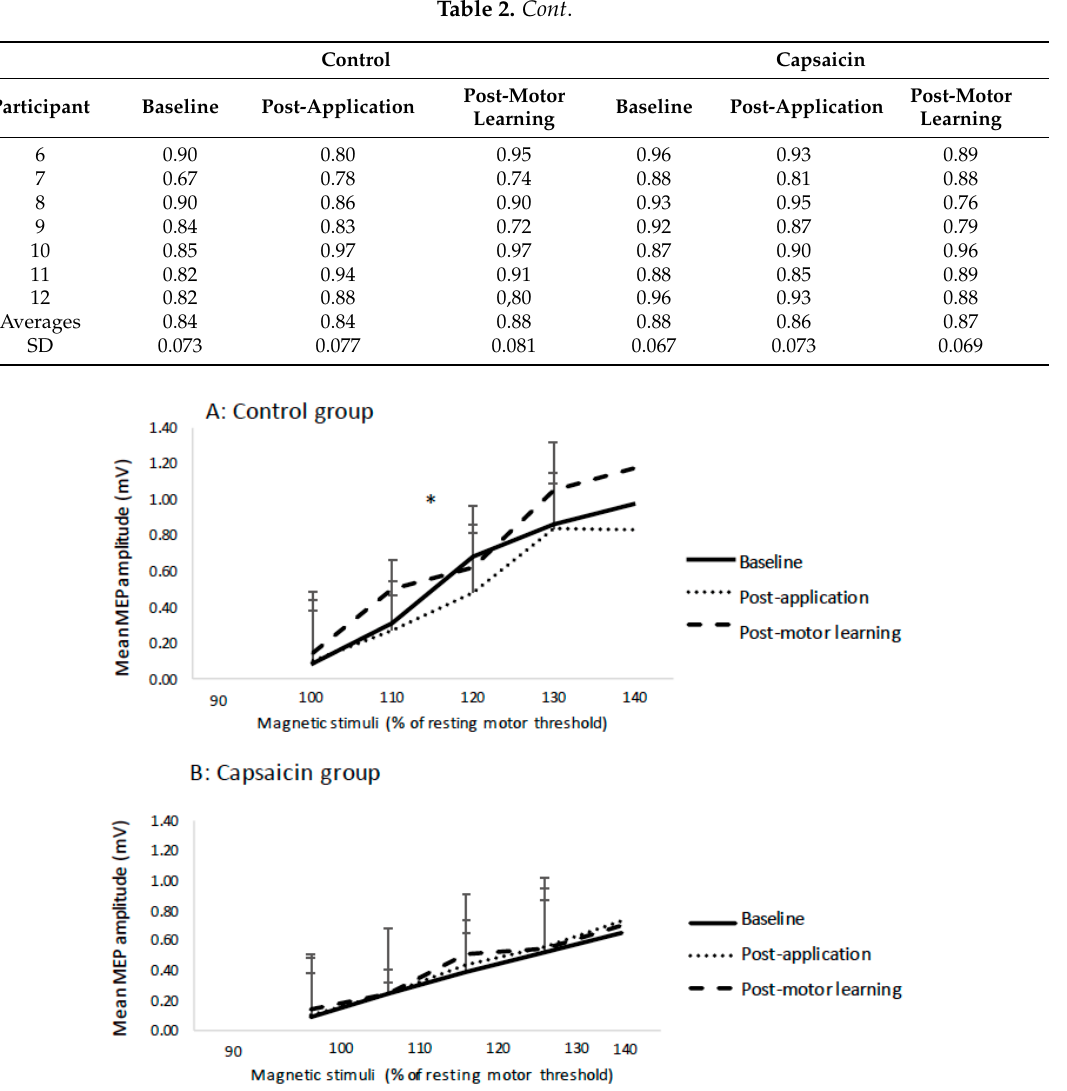
Figure 8. Mean IO curves of control ( A ) and capsaicin ( B ) groups. Note the increase in mean slope for the control ( A ) group as indicated by an asterisk. Error bars represent the standard deviation.